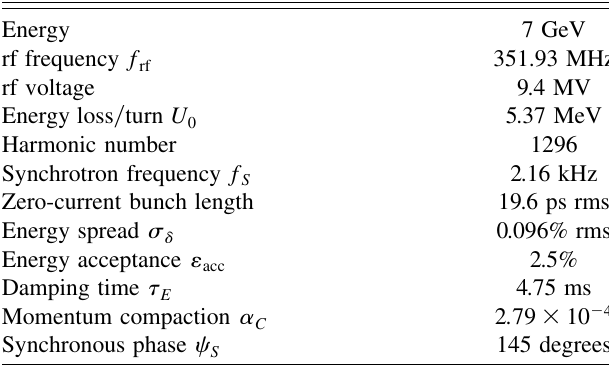
TABLE I. Nominal APS longitudinal phase-space parameters. Energy 7 GeV